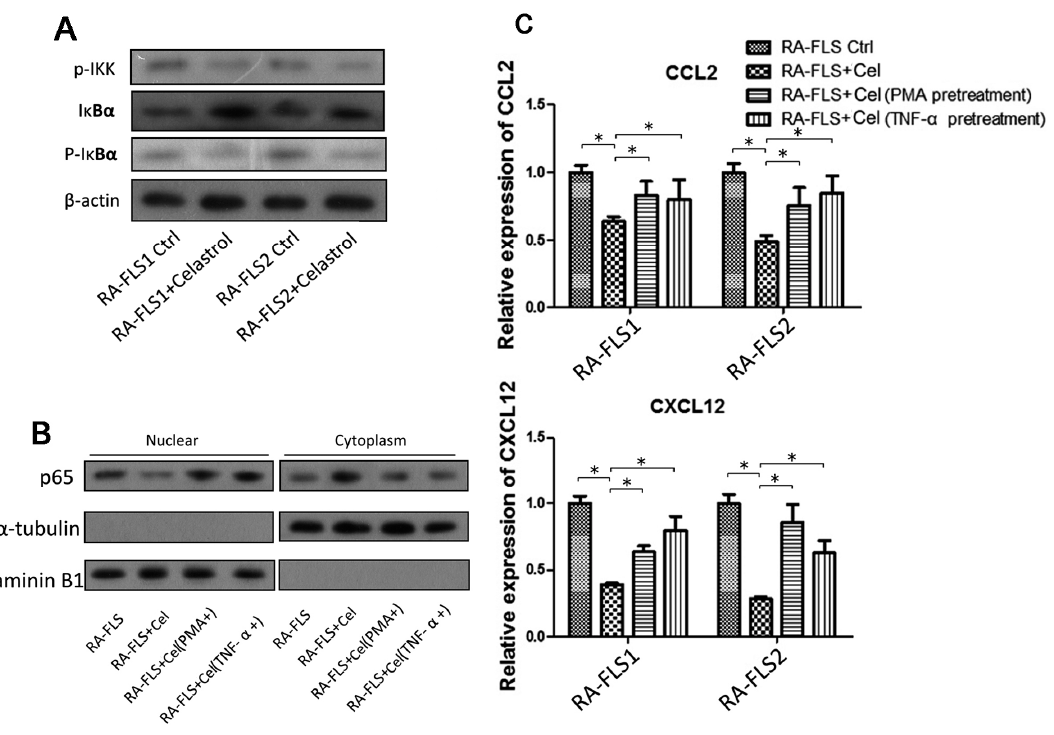
Figure 4. NF- κ B signaling pathway might be involved in celastrol-suppressed chemokine production. ( A ) Total cell lysates of RA–FLS1 and 2 cells treated with or without celastrol (1 µM) were examined by Western blotting. ( B ) Subcellular fractionation was performed as described in the Materials and Methods Section; nuclear and cytoplasmic lysates of RA–FLSs with or without celastrol treatment were examined by Western blotting. ( C ) After RA–FLS1 and 2 cells were treated with celastrol (1 µM) or celastrol (1 µM) together with pretreatment of two NF- κ B activators (PMA and TNF- α ), real-time PCR analysis was carried out to examine the mRNA expression of CCL2 and CXCL12. Data bars represent the mean value ± SD from triplicate wells from three separate experiments using RA–FLS1 and 2 cells. * p < 0.05 versus RA-FLS1/2 treated with celastrol.